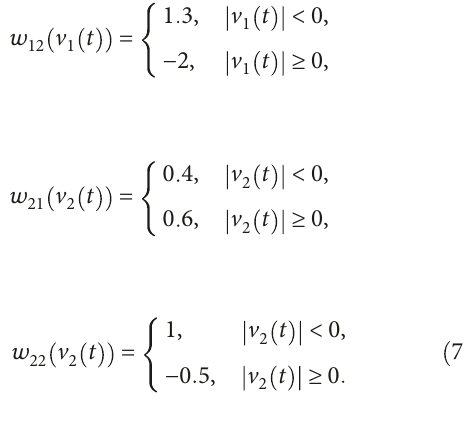
Figure 1: (a) The trajectories of state variables v v t in (69) with the discontinuous state feedback controller 2